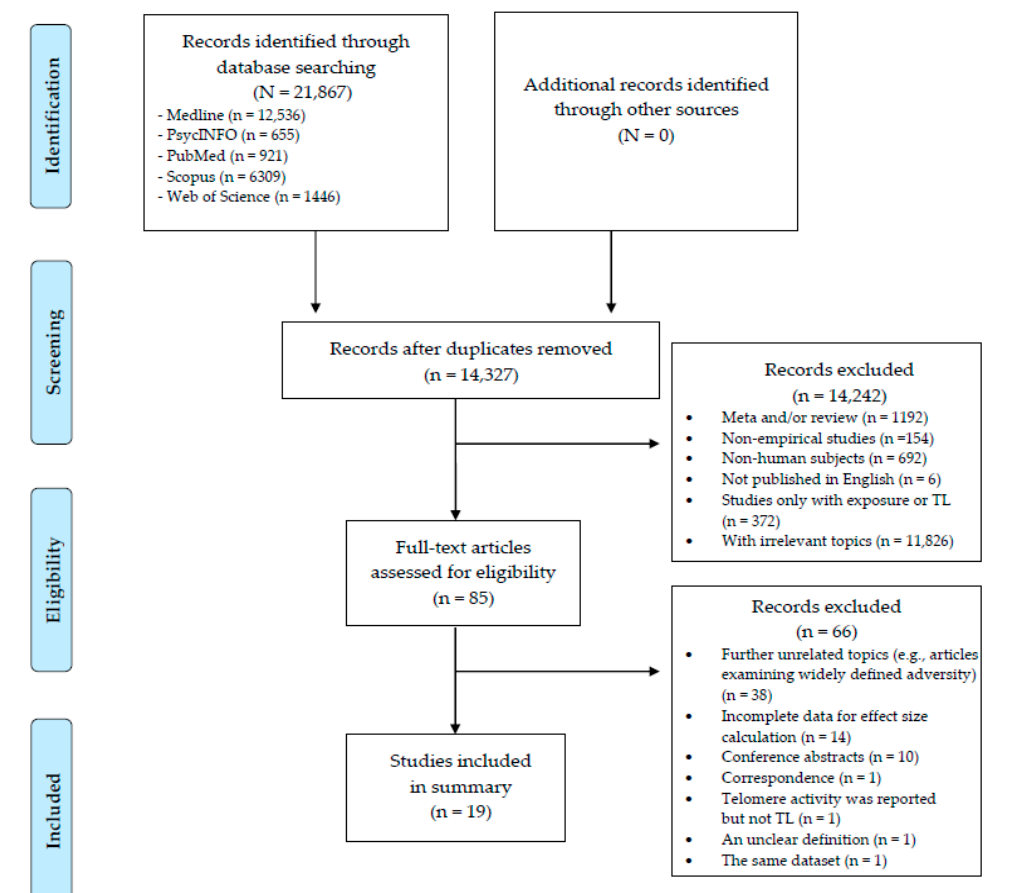
Figure 1. Flow diagram of the study selection process.